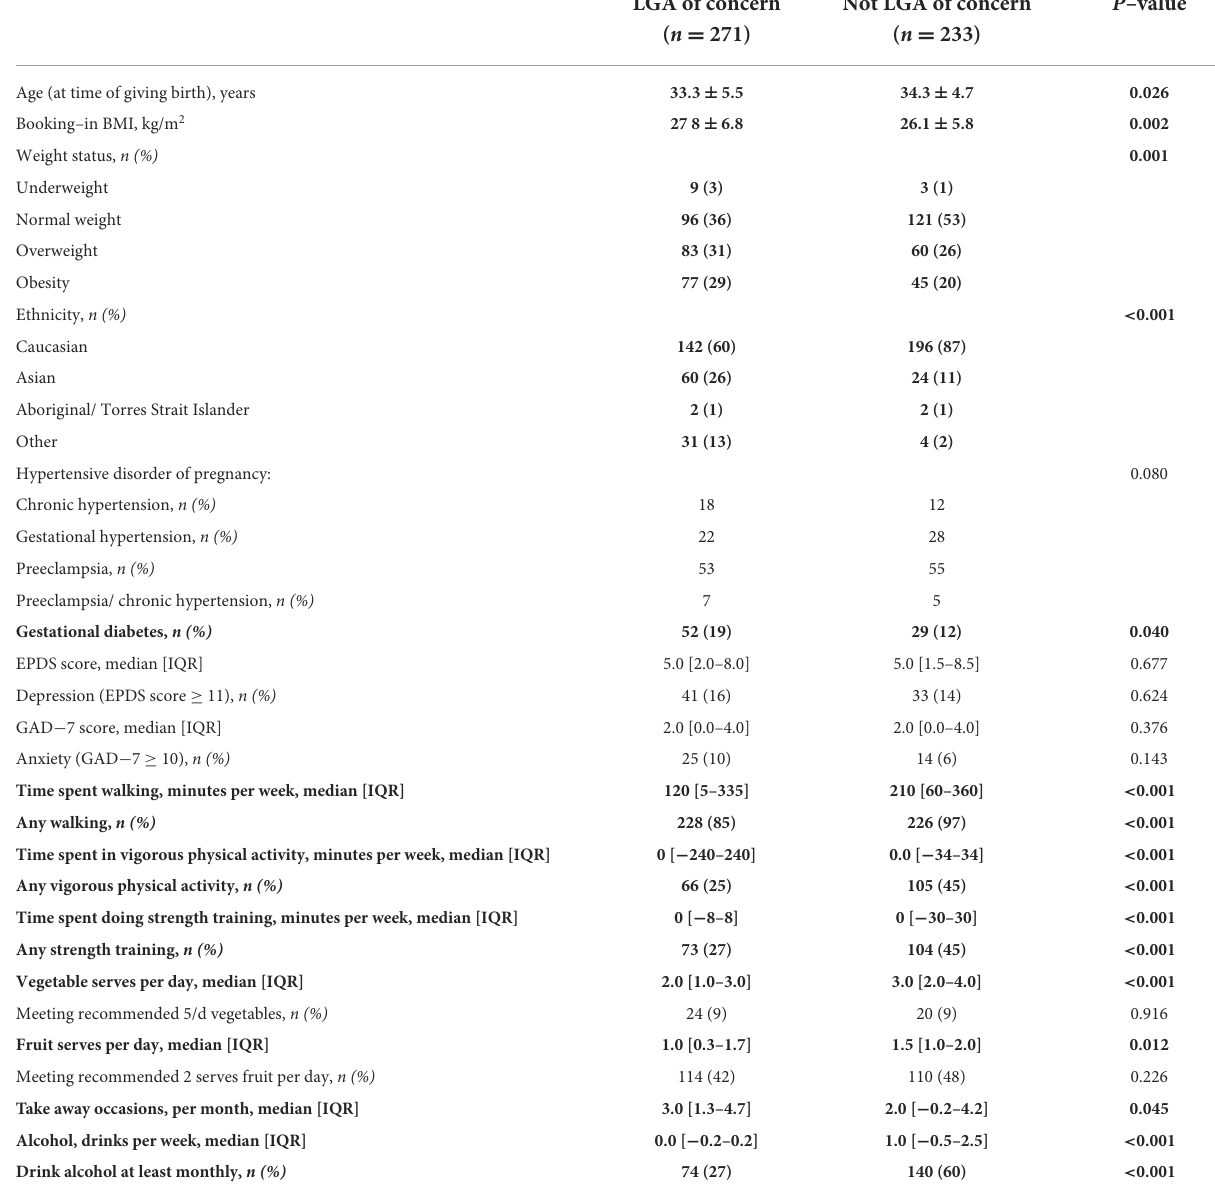
TABLE 3 Characteristics of women at 6–months postpartum participating in the BP 2 study who lived in a Local Government Area of concern vs. those who did not live in a Local Government Area of concern at time of study entry *